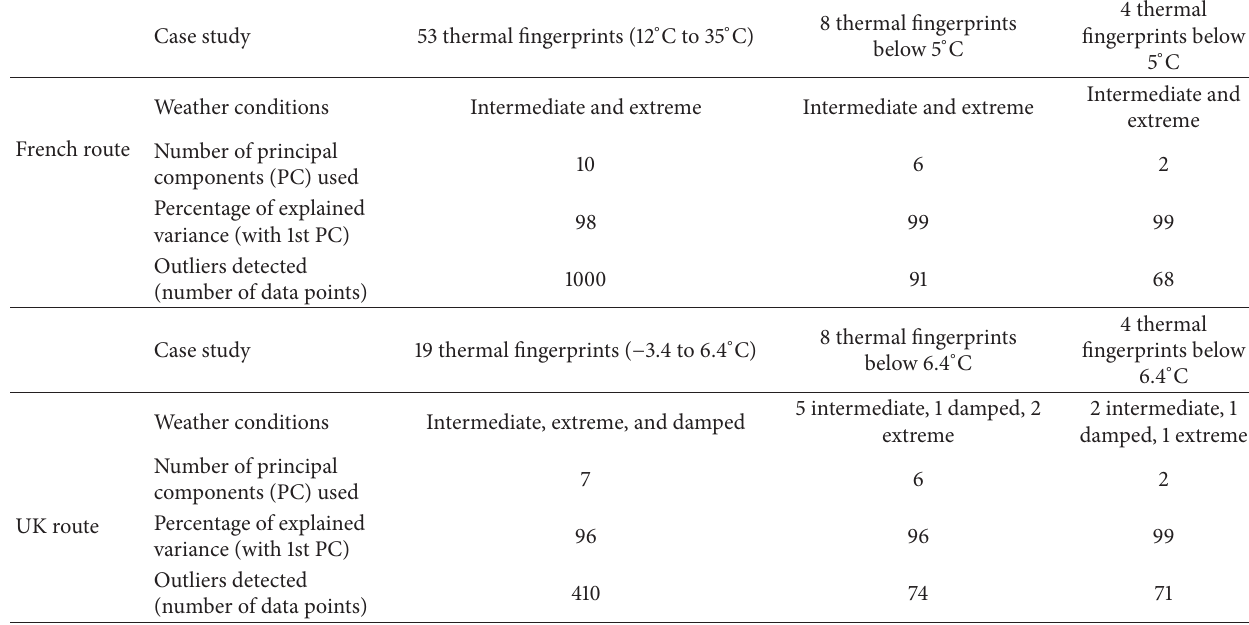
Table 1: PCA statistical indicators for the French and UK routes.